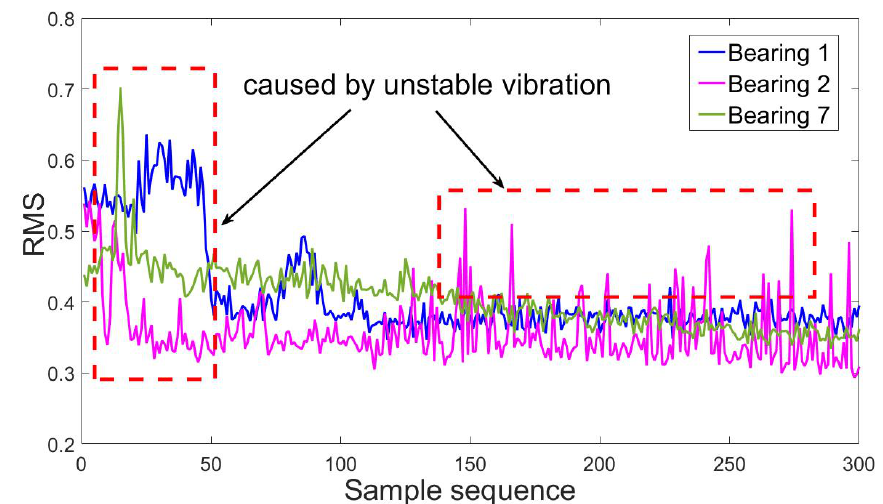
Figure 2. RMS curves of the first 300 sample points of bearings 1, 2 and 7 under the first working condition from IEEE PHM Challenge 2012